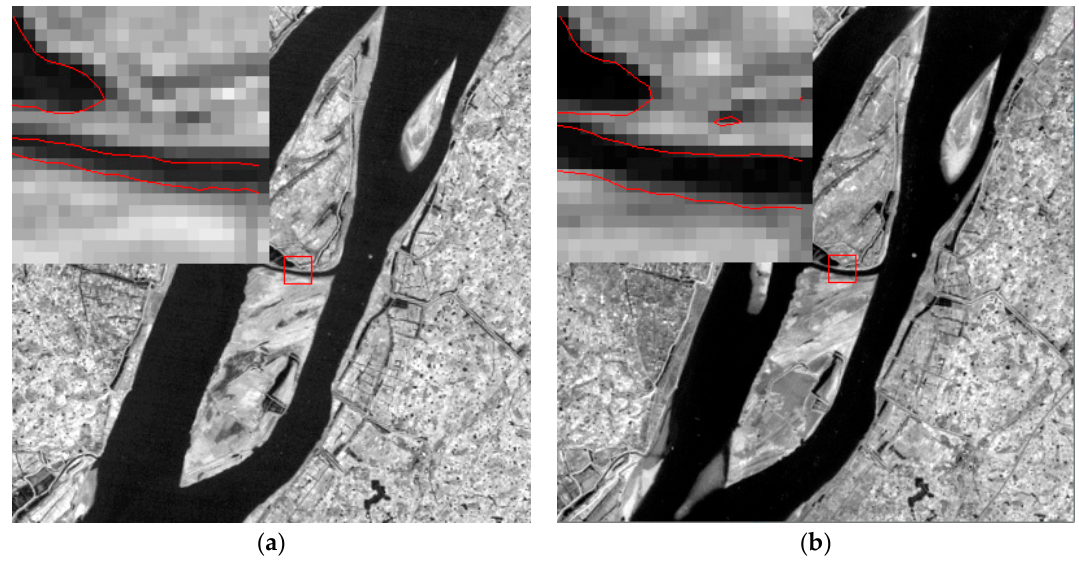
Figure 11. Before-and-after images of mid-channel between Xinjizhou and Xinshengzhou (( a ) 7 February1998; ( b ) 19 December1999).